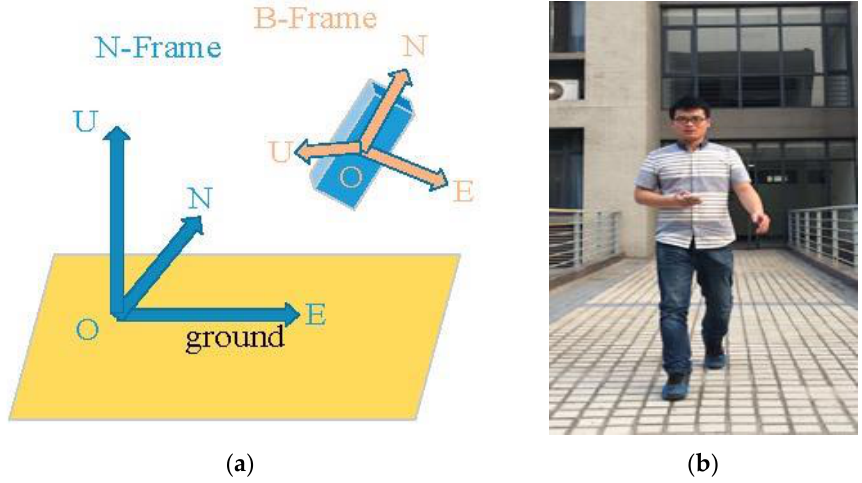
Figure 2. Measurement setup. ( a ) Illustration of the two coordinate systems; ( b ) Test subject holding a phone.